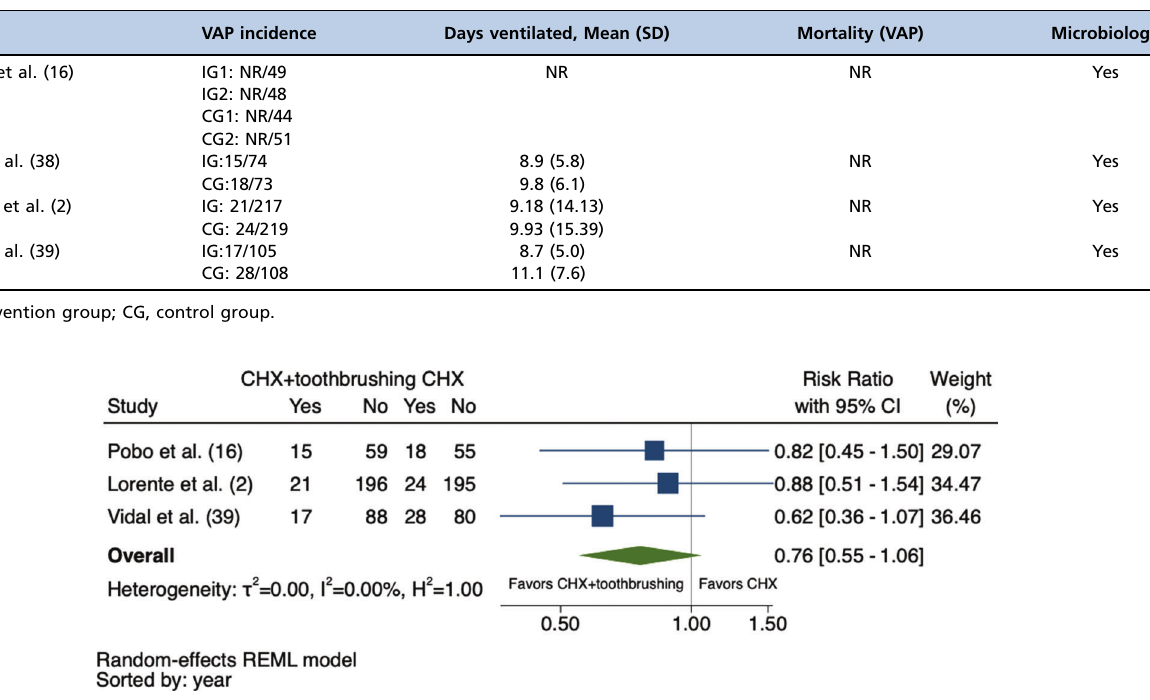
Figure 2 - Forest plot comparing the CHX 0.12% + toothbrushing and CHX 0.12% alone